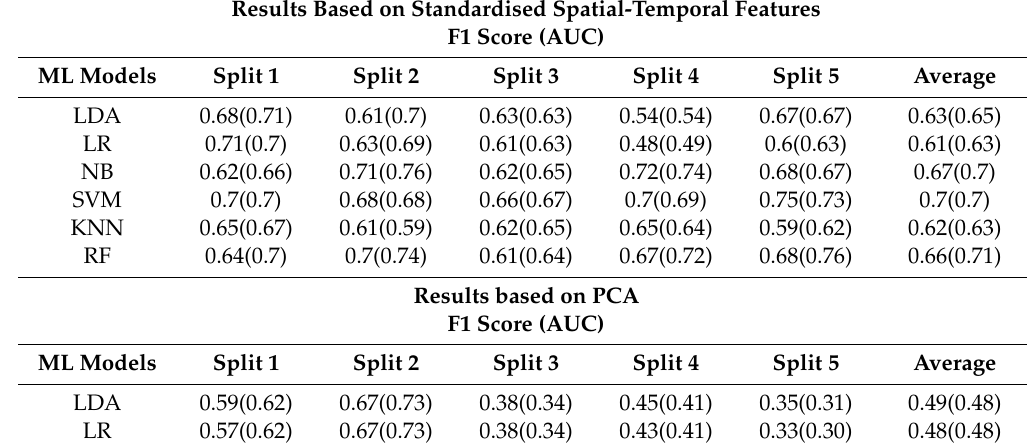
Table A2. ML model results for F1 Score and AUC. Results Based on Standardised Spatial-Temporal